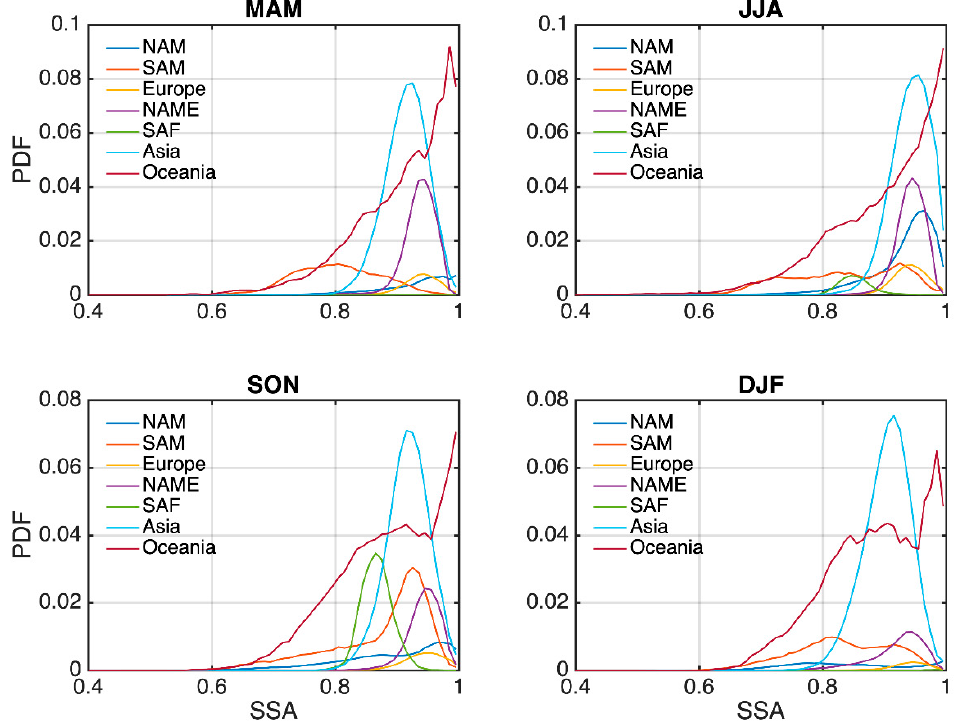
Figure 20. Probability density function of AERONET SSA values for the four seasons over the seven